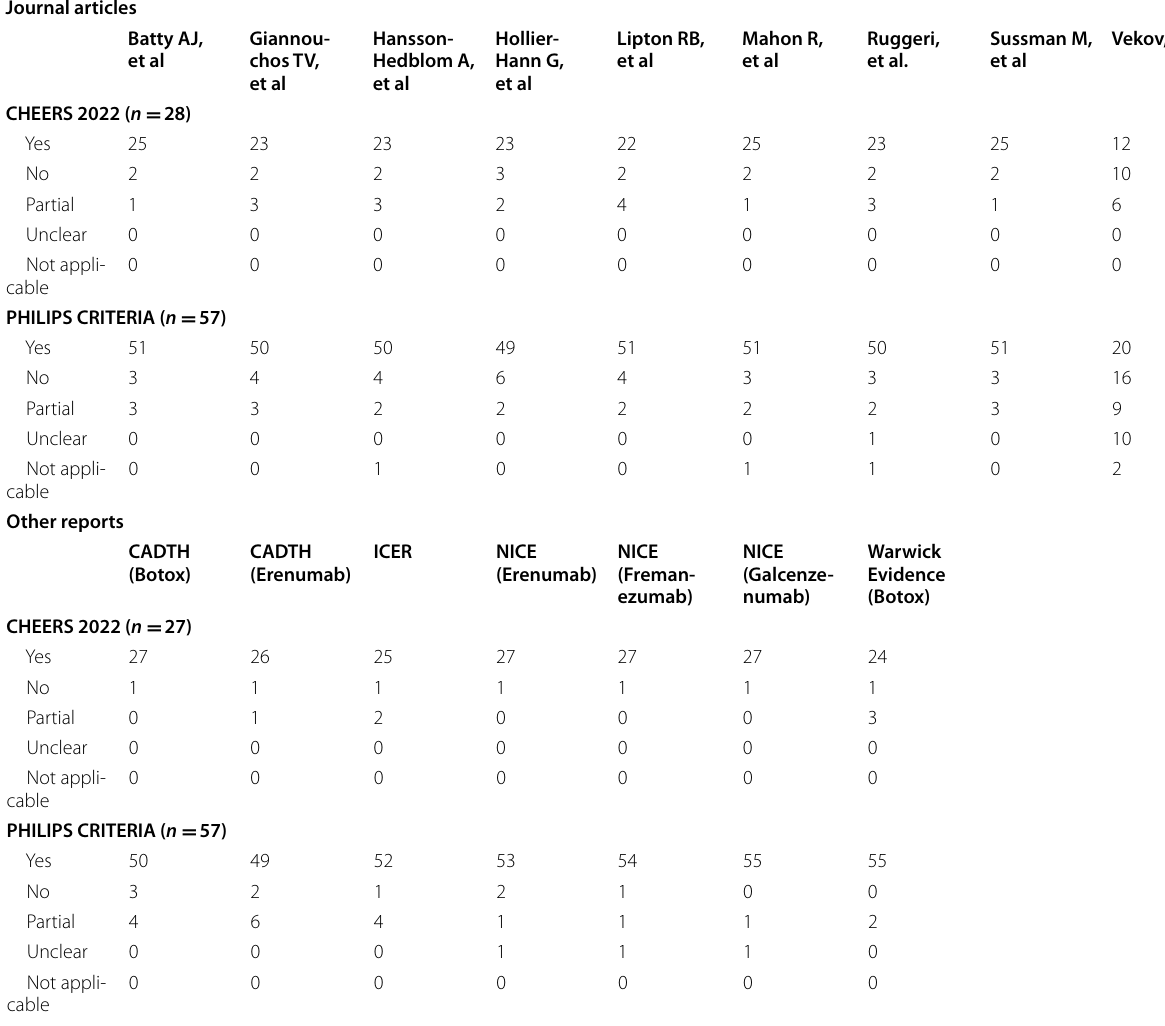
Table 5 Number of quality assessment criteria addressed by individual studies Journal